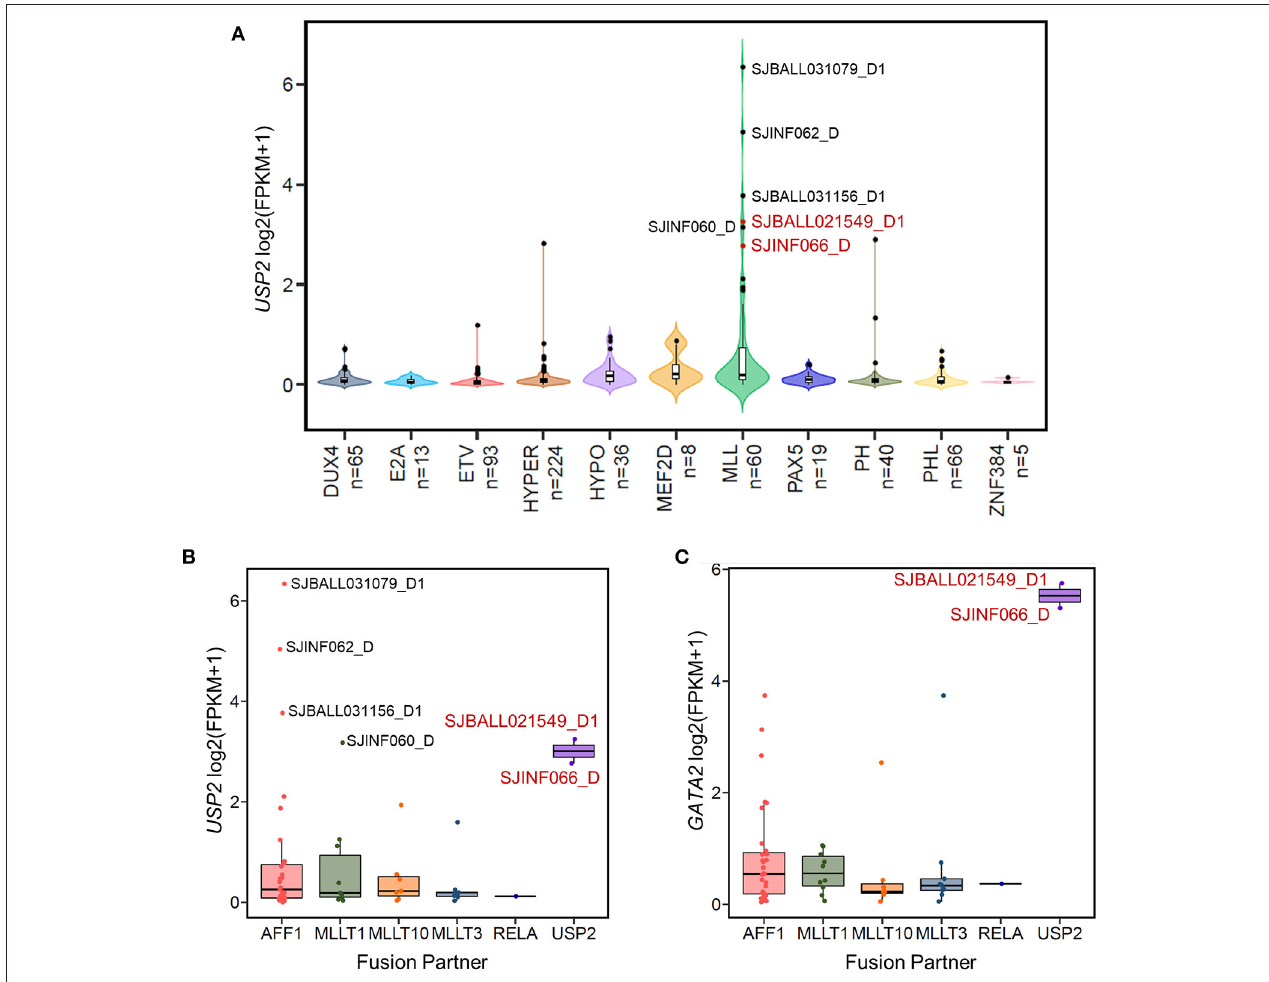
FIGURE 4 | The KMT2A-USP2 fusion activates GATA2 in B-ALL. (A) The expression of USP2 in 629 B-ALL patients across 11 subtypes. Six MLL B-ALL patients with USP2 FPKM values > 5 are labeled with the corresponding sample IDs. Two patients with the KMT2A-USP2 fusion are highlighted in red. (B) Boxplot showing USP2 transcription in patients with the MLL subtype of B-ALL. Cases were further divided into groups according to KMT2A fusion partner. Six USP2 -positive MLL cases are labeled and color coded as in (A) . (C) The expression of GATA2 across different fusion partner groups in MLL subtypes as shown in (B)